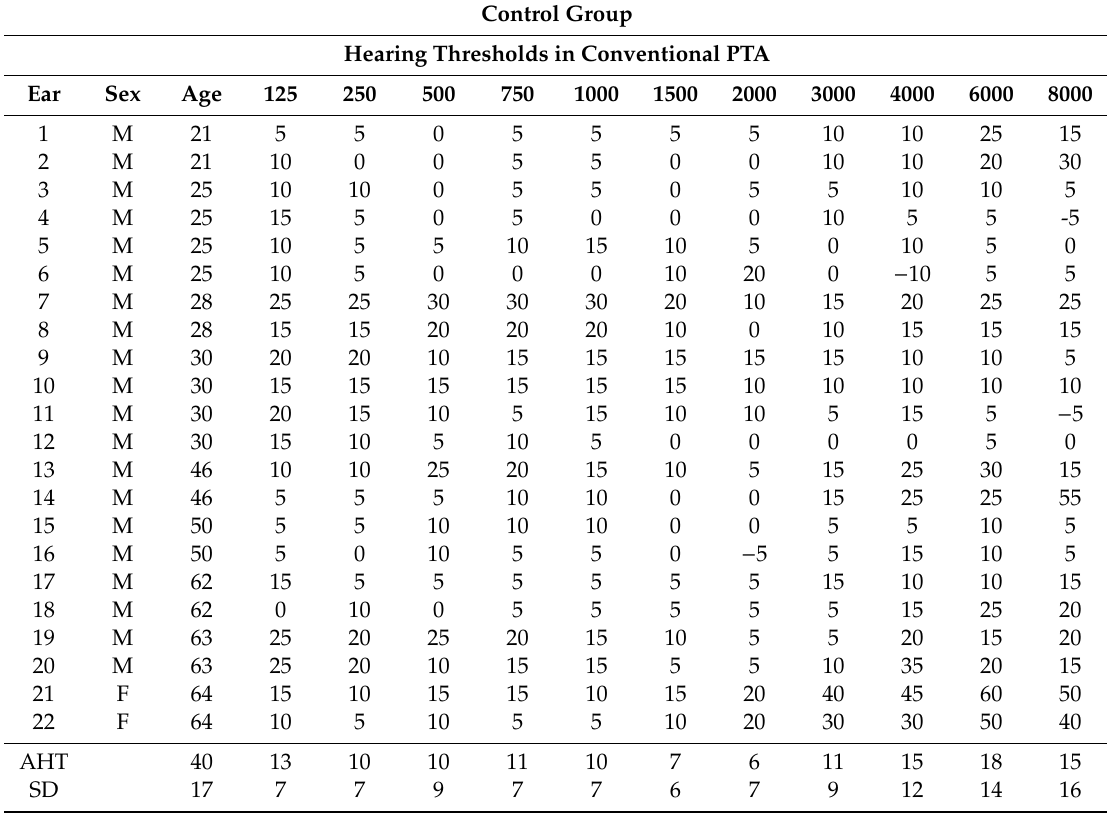
Table 7. Hearing thresholds of the bell ringers with values corrected by age. Control Group